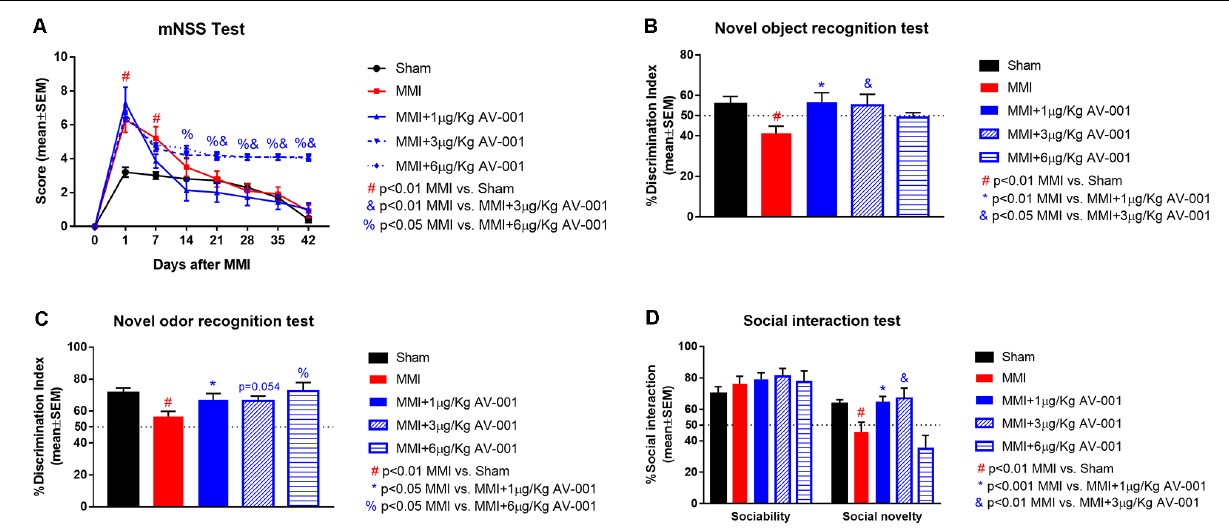
FIGURE 2 | AV-001 treatment significantly improves cognition and memory in middle-aged rats subjected to MMI. (A) There were no significant differences in modified neurological severity score (mNSS) after 1 µ g/Kg AV-001 treatment compared to the MMI control group. However, 3 or 6 µ g/Kg AV-001 treatment group exhibited significantly worse neurological function compared to MMI control group. (B) Compared to Sham control rats, middle-aged rats subject to MMI exhibit significant short term memory impairment indicated by lower discrimination index in the novel object recognition test. Rats treated with 1 or 3 µ g/Kg AV-001 exhibit significantly improved short-term memory compared to MMI rats. (C) Compared to Sham control rats, middle-aged rats subject to MMI exhibit significant long term memory impairment indicated by lower discrimination index in the novel odor recognition test. Rats treated with 1 or 6 µ g/Kg AV-001 exhibit significantly improved long-term memory compared to MMI rats. (D) Compared to sham control rats, middle-aged rats subject to MMI exhibit significantly reduced preference for social novelty in the social interaction test. Rats treated with 1 or 3 µ g/Kg AV-001 exhibit significantly improved preference for social novelty compared to MMI rats.